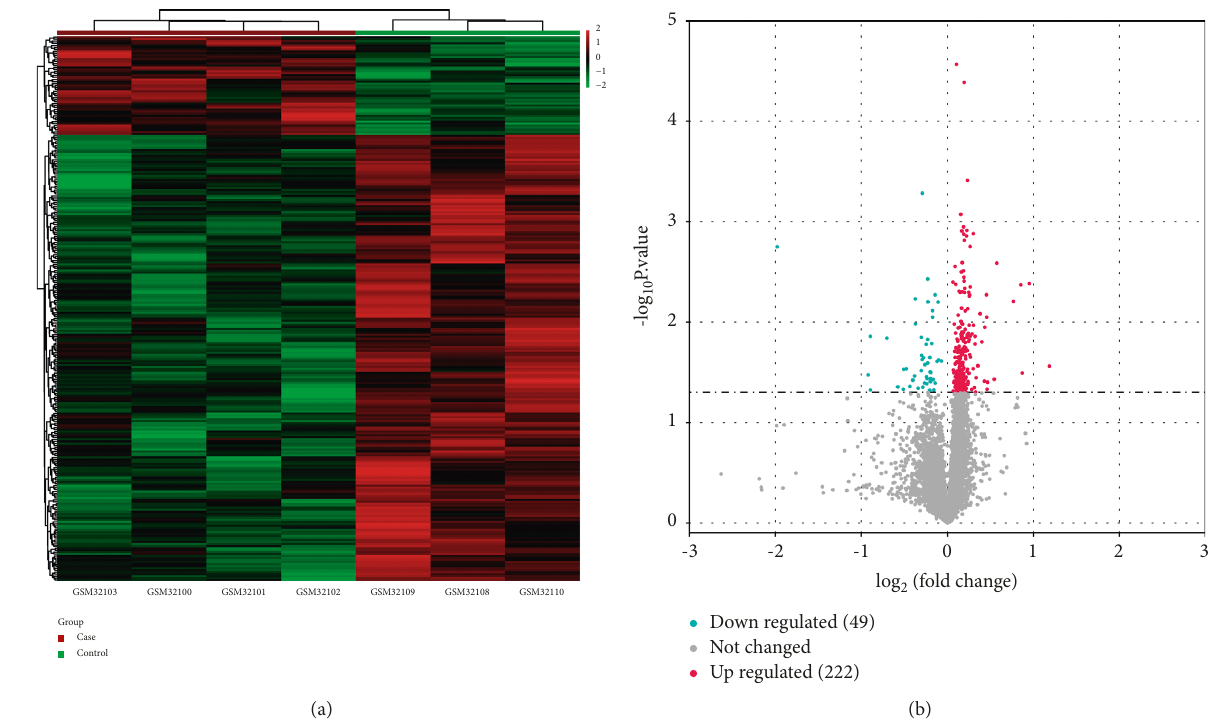
Figure 1: Differential analysis of DEGs. (a) Heat map of DEGs. The red part represents the case group, which is a sample of 3 cases 18 hours after exercise. The green part represents the control group, which is a sample of 6 hours after 4 exercises. (b) Volcano map of DEGs. Blue dots represent the downregulated DEGs, and red dots represent the upregulated